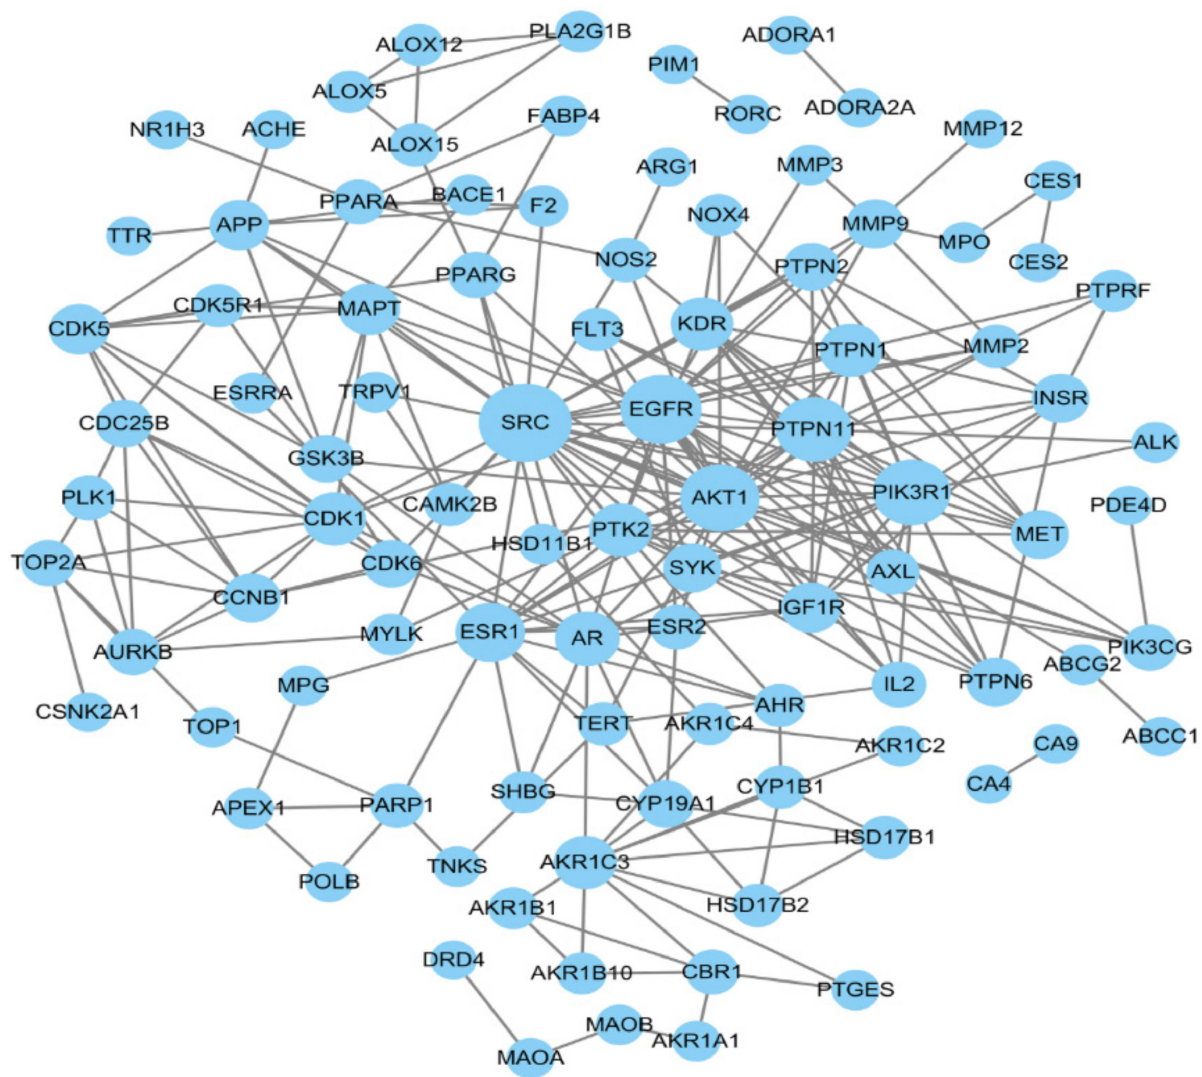
Figure 3. The PPI network of targets. Node size represents degree